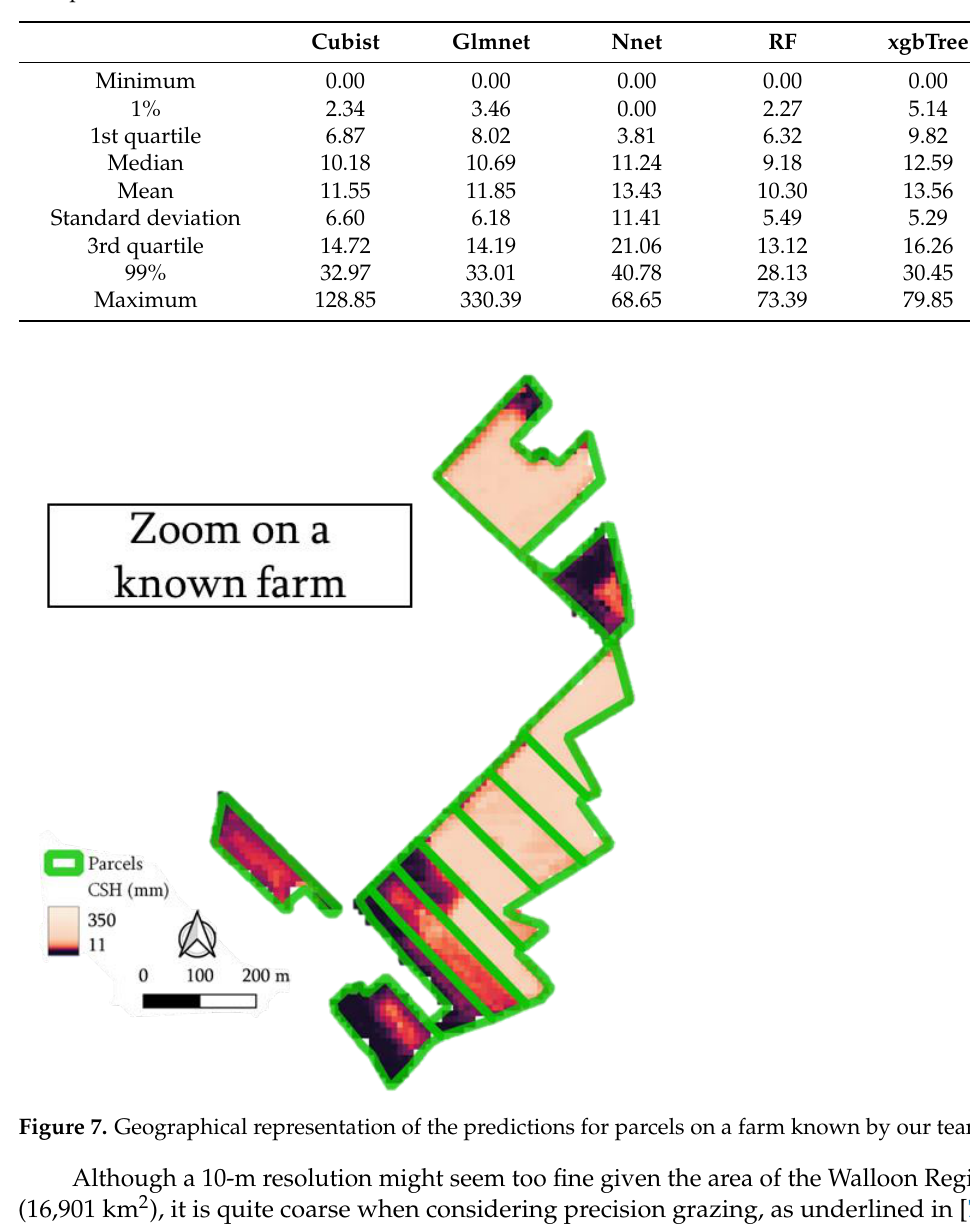
20 of 26 Table 7. Descriptive statistics of the coefficient of variation of the CSH computed for each date for